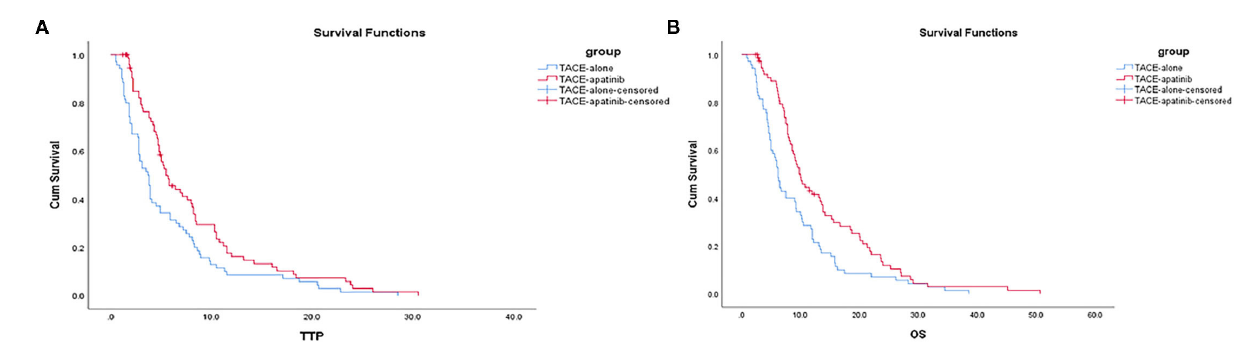
the difference was statistically significant ( P < 0.05). All these adverse events disappeared after symptomatic